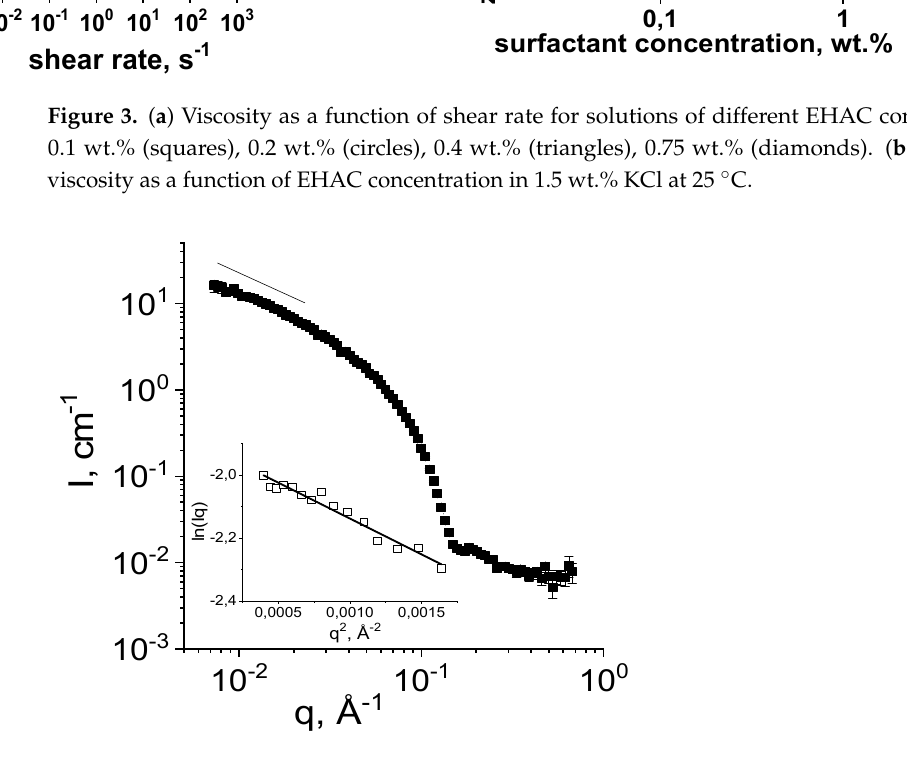
Figure 4. SANS profile for 0.6 wt.% aqueous solutions (D 2 O was used as a solvent) of EHAC cationic surfactant at 1.5 wt.% KCl at 25 ◦ C. Solid line shows the slope of I~q − 1 dependence. The inset graph represents the dependence of ln(Iq) on q 2 revealing the cylindrical local shape of WLMs.